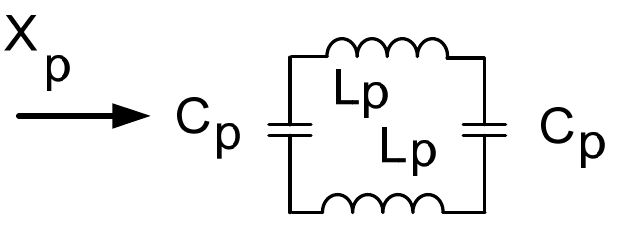
Figure 7. Basic structure of ring-type passive filter.